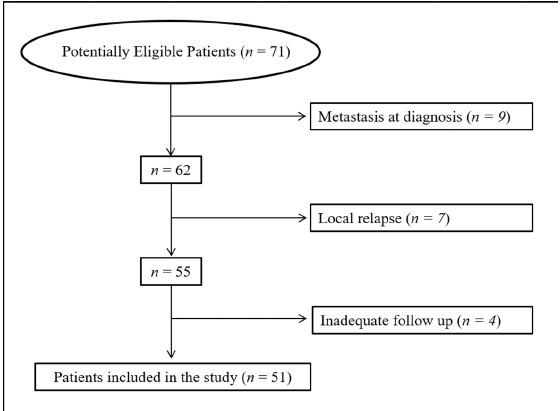
Figure 1. Flow chart of the patient selection process